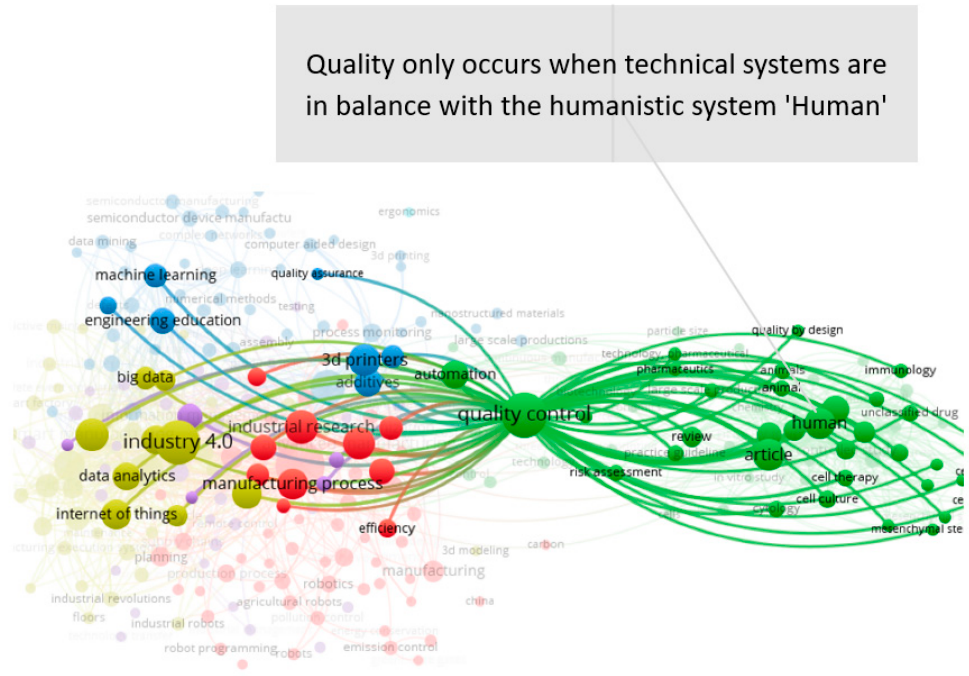
Figure 19. VOSviewer: The QUALITY focus in the context of extended production control.